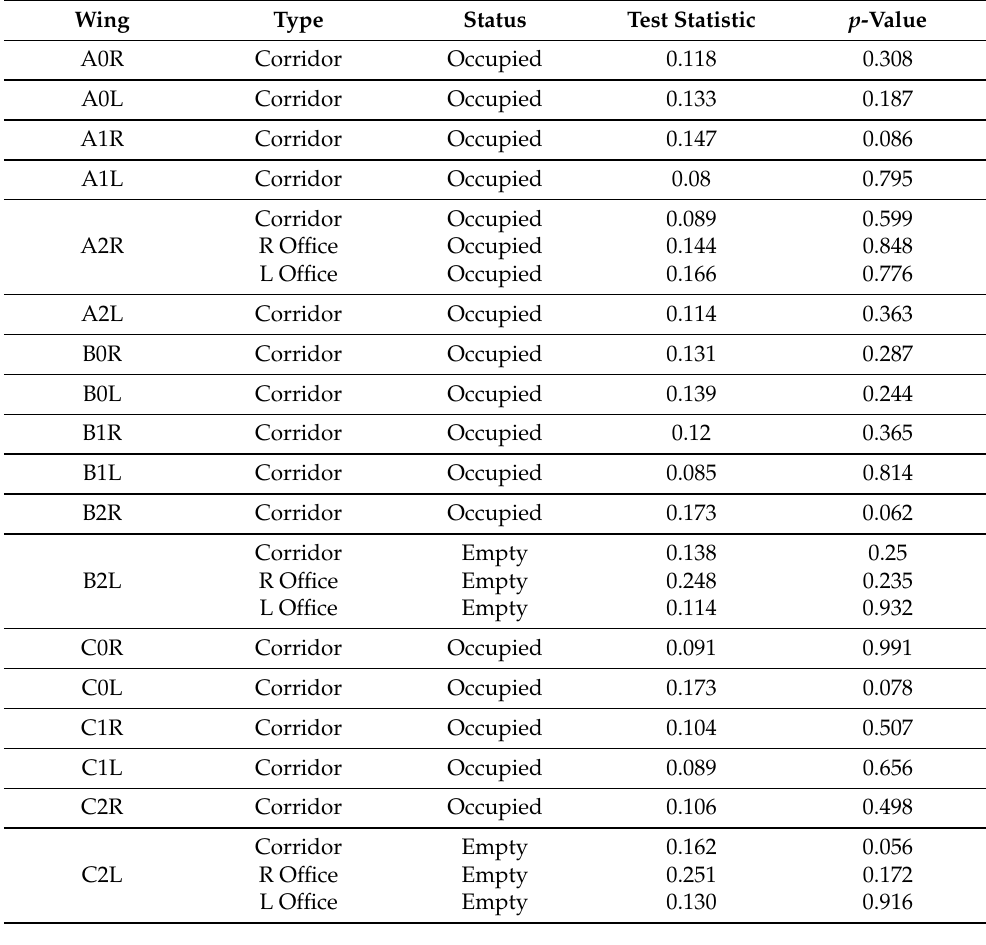
Table 6. K-S Test checking the normality of exposure on all wings of building A, B, and C.